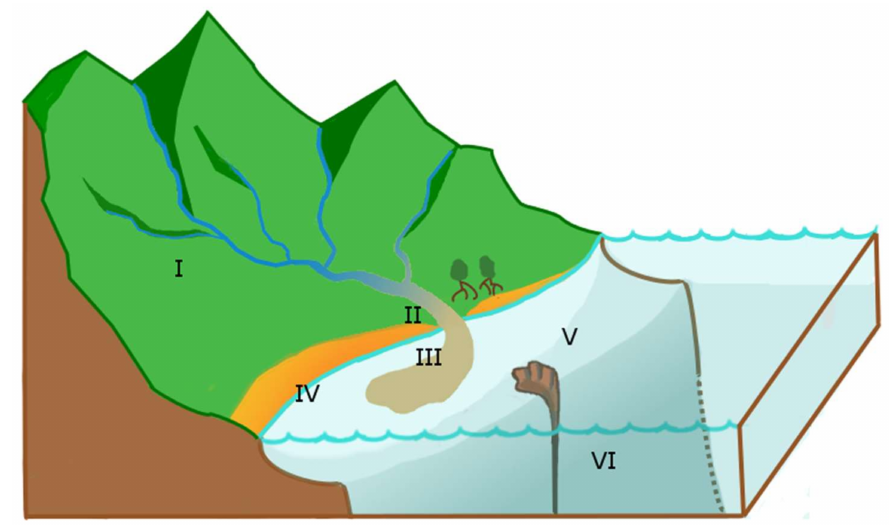
Figure 1. 6 main domains/geomorphological units of sediment transport studies. I the watershed; II estuary/delta; III the estuary-littoral transition, including the river plume, the bottom nepheloid